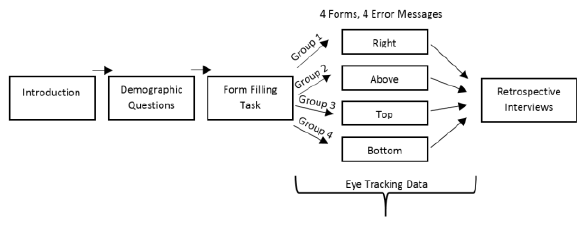
Figure 2. Overview of the experimental procedure An eye-tracking device was used to record the partici- pants’ eye movements. The participants were asked to think aloud during the experiments and their feedbacks were recorded in the form of notes. The researcher did not intervene in the form-filling process, but, at the end of the experiment, asked participants to discuss about the record- ing of their behavior during the experiment. Each retro- spective interview lasted approximately 20 minutes about locations of error messages in Web forms.